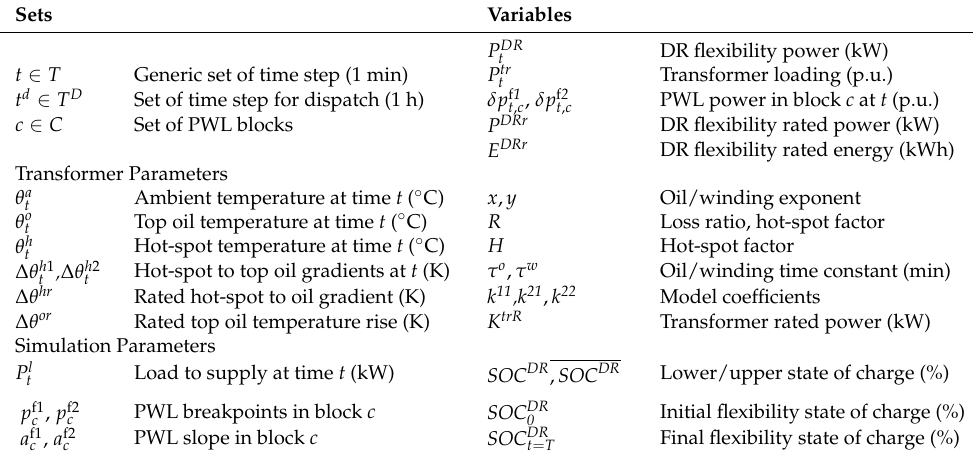
Table 3. List of the used